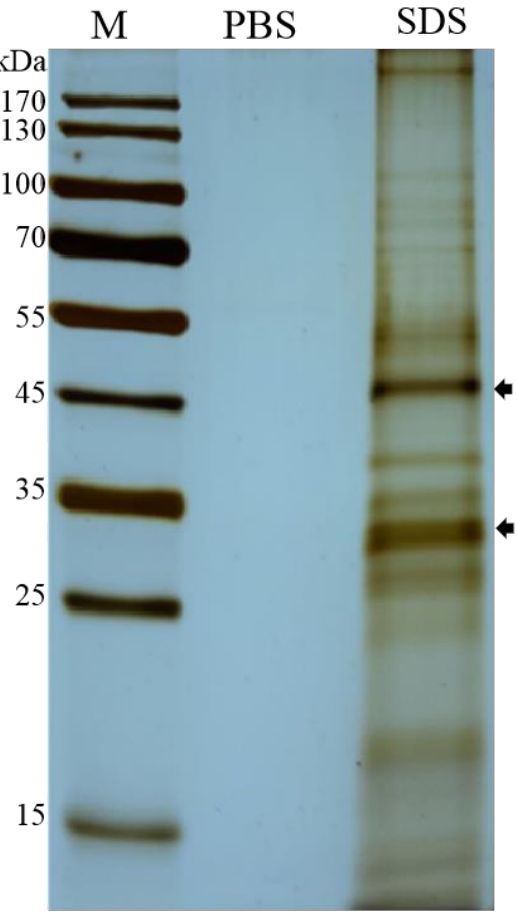
Figure 2. SDS-PAGE analysis of surface proteins of Enterocytozoon hepatopenaei spores. Lane M: protein maker; lane PBS: proteins extracted with 0.01 M PBS (pH 7.4); lane SDS: proteins extracted with 1% SDS. Table 1. Overview of protein identification, annotation, and enrichment